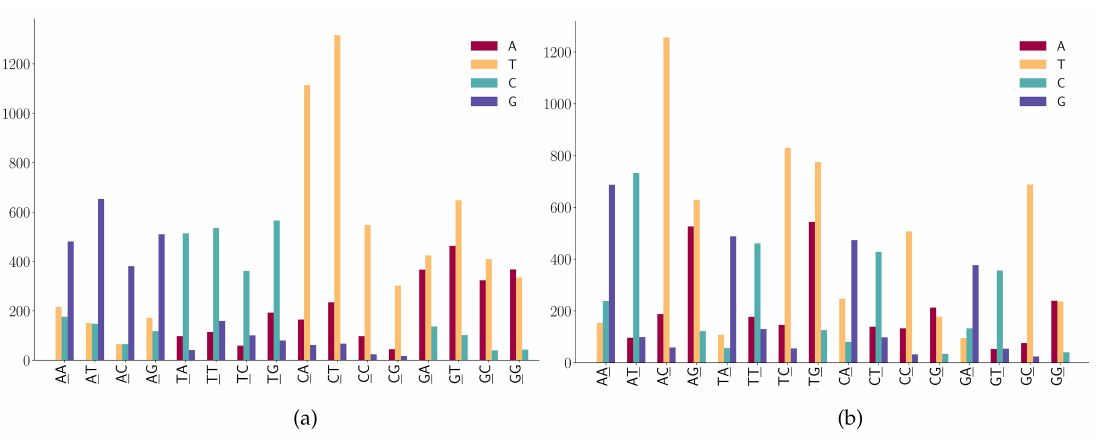
Figure 6. SNP frequencies on 2-mer motifs. ( a ) SNP frequencies are at the first position of 2-mer motifs. ( b ) SNP frequencies are at the second position of 2-mer motifs.